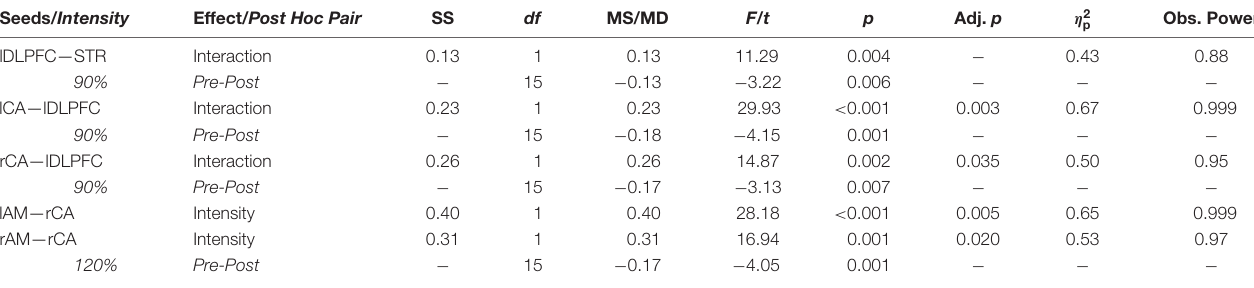
TABLE 1 | Statistically significant seed-to-seed functional connectivity (FC) results. Seeds/